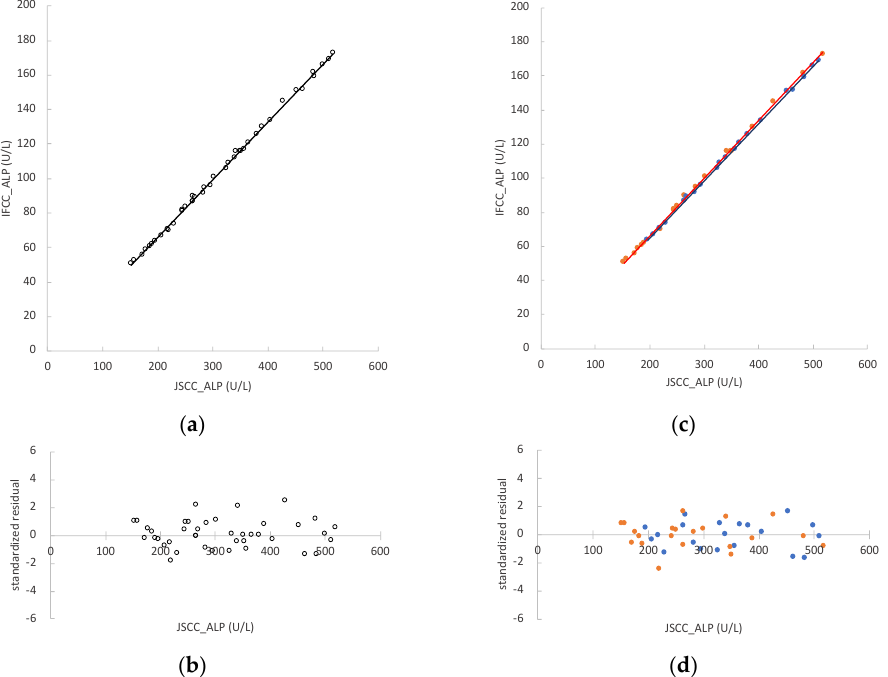
Figure 3. Correlation between alkaline phosphatase (ALP) activities measured by the Japan Society of Clinical Chemistry (JSCC) and International Federation of Clinical Chemistry and Laboratory Medicine (IFCC) methods in mouse serum samples. The x-axes represent the values obtained by the JSCC method, and the y-axes represent those obtained by the IFCC method: ( a ) regression analysis comparing JSCC and IFCC values of all samples ( n = 41), represented by the formula y = 0.335x − 1.274; ( b ) standardized residual plots obtained using the regression equation of all samples ( n = 41); ( c ) regression analysis comparing JSCC and IFCC values of fed mice ( n = 21, orange dots) and fasted mice ( n = 20, blue dots), represented by the formulas y = 0.339x − 1.515 and y = 0.336x − 2.247, respectively; ( d ) standardized residual plots obtained using the regression equations of fed mice ( n = 21, orange dots) and fasted mice ( n = 20, blue dots).